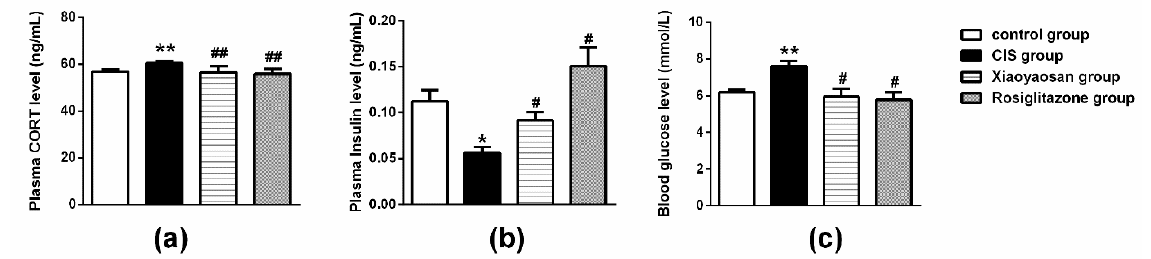
Figure 4. Effects of Xiaoyaosan on plasma CORT, insulin and blood glucose levels in stress-induced rats. ( a ) Plasma CORT levels. ( b ) Plasma insulin levels. ( c ) Blood glucose levels. Data are presented as the means ± SEM from eight rats in each group for determination. * p <0.05 or ** p < 0.001 versus the control group. # p < 0.05 or ## p < 0.001 versus the CIS group.